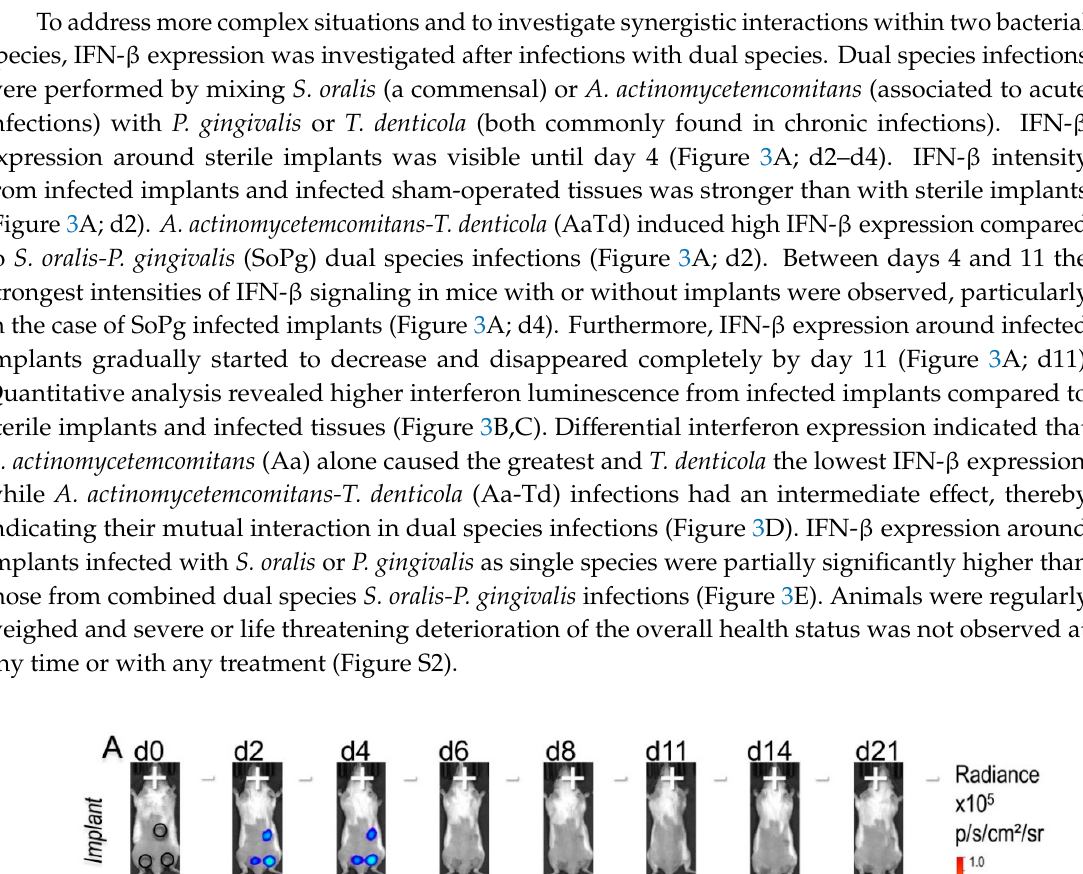
Figure 3. IFN ‐β induction upon dual species infections. ( A ) IFN ‐β luminescence measured at the indicated time points in days from sterile implants, infected implants (+), infected surgical pouches without implants ( − ). Bioluminescent images from a typical single experiment. Implantation sites were marked as region of interest and bioluminescent signals were quantified as radiance at the indicated time points ( B , C ). ( B ) IFN ‐β kinetics upon A. actinomycetemcomitans ‐ T. denticola (AaTd) dual species infections of implants (blue squares with borders), tissues (blue squares). ( C ) IFN ‐β kinetics upon S. oralis ‐ P. gingivalis (SoPg) dual species infections of implants (purple squares with borders), tissues (purple squares). ( D ) Comparison of Aa and Td implant infections as single species with AaTd dual species implant infections. ( E ) Comparison of So and Pg implant infections as single species with SoPg dual species infections. Three animals, each carrying three implants were used in each group yielding n = 9 biological observations. Error bars indicate mean ± s.e.m. Significance values have been adjusted by the Bonferroni correction for multiple tests. Symbols ***, *, and # indicate p < 0.001, p < 0.05, and significant p value prior to Bonferroni correction, respectively. Black symbols represent p values between sterile and infected implants ( B , C ). Colored symbols indicate p values between implants infected with single species to dual species infected implants ( D , E ).